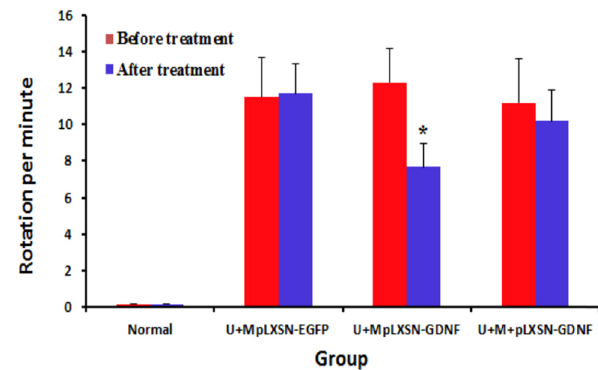
Figure 2: Detection of GDNF protein expression in the substantia nigra of rats from each group by western blot analysis. ( a ) Expression of GDNF protein in the substantia nigra of rats from each group; ( b ) relative optical density analysis; compared with the normal group and U + MpLXSN - EGFP group, * P < 0.05.